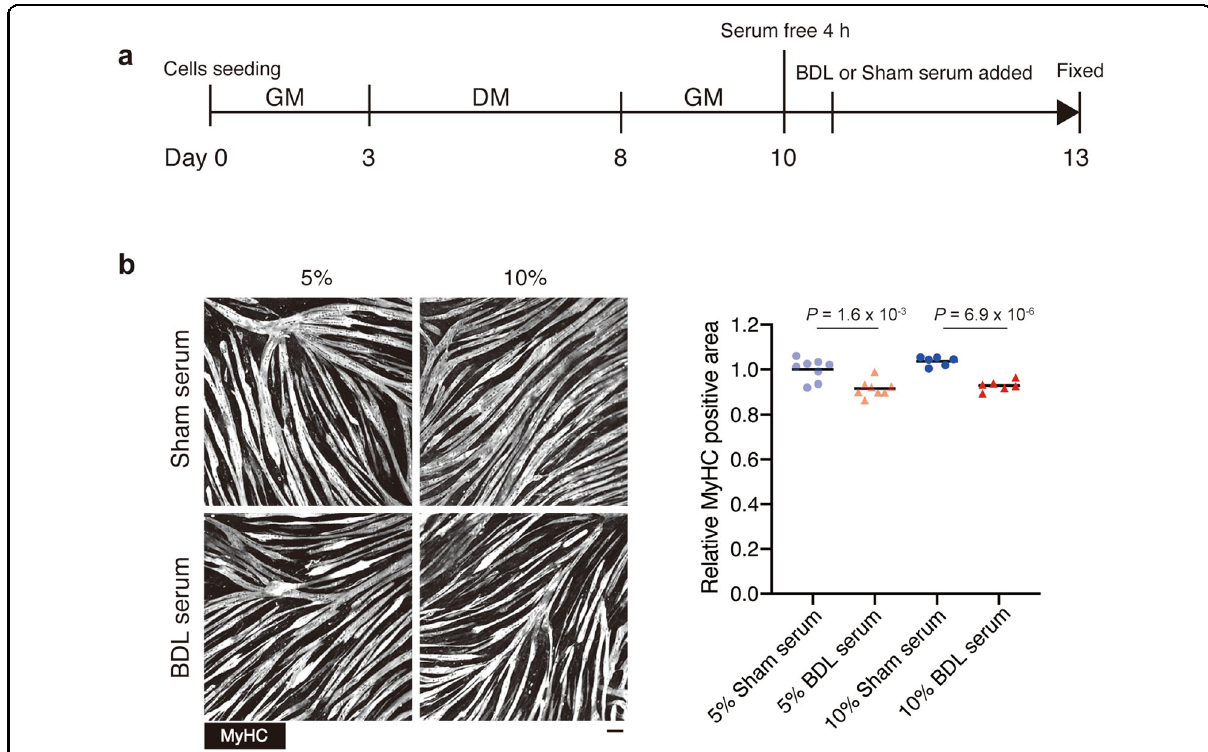
Fig. 3 Serum from BDL mice induces myotube atrophy. a Experimental design for examining the effect of serum factors on mature human myotubes. b Serum-treated myotubes were stained for MyHC (left) and the MyHC-positive area was quanti fi ed (right). n = 8 or 6 independent wells for 5% or 10% serum treatment, respectively. Data represent individual data points and the means. Data were analysed using the two-sided unpaired t -test. Scale bar, 100 μ m ( b